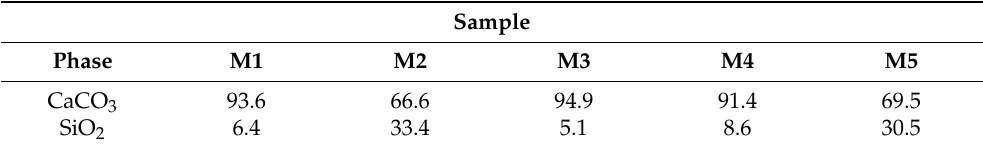
Table 6. The volume fraction of the two identified phases in all specimens as per a semi-quantifica- tion procedure.